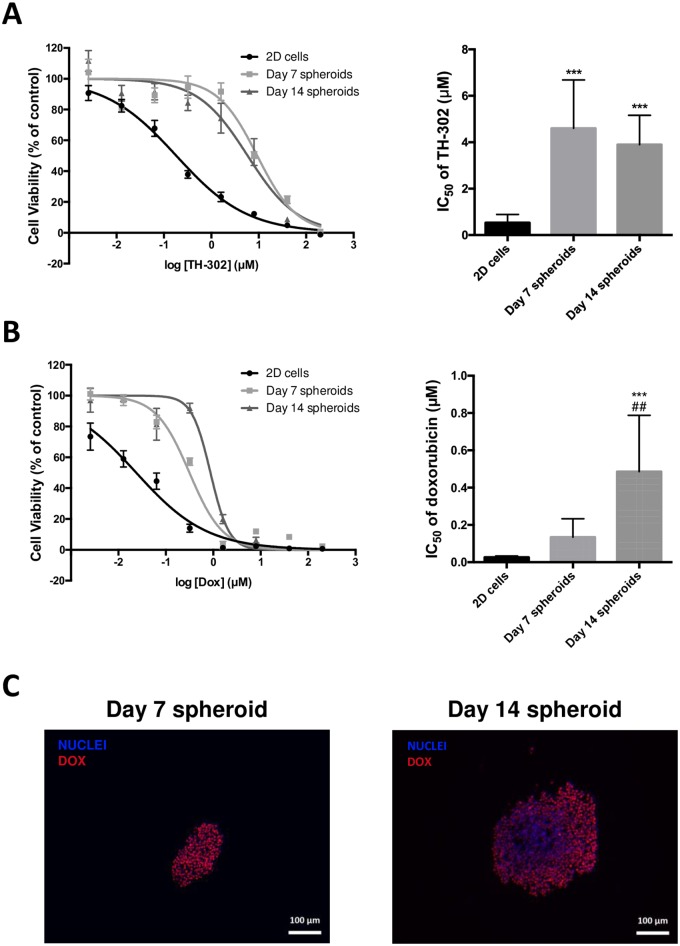
Assessment of cytotoxicity of TH-302 (A) and doxorubicin (B) on Day 7 and Day 14 spheroids relative to cells cultured in a monolayer.Cultures were exposed to drugs for 72 h. * significant difference versus 2D cells; # significant difference versus Day 7 spheroids. (C) Doxorubicin penetration on Day 7 and Day 14 spheroid sections evaluated by fluorescent microscopy; spheroids were incubated with doxorubicin at a final concentration of 75 μM for 2 h.